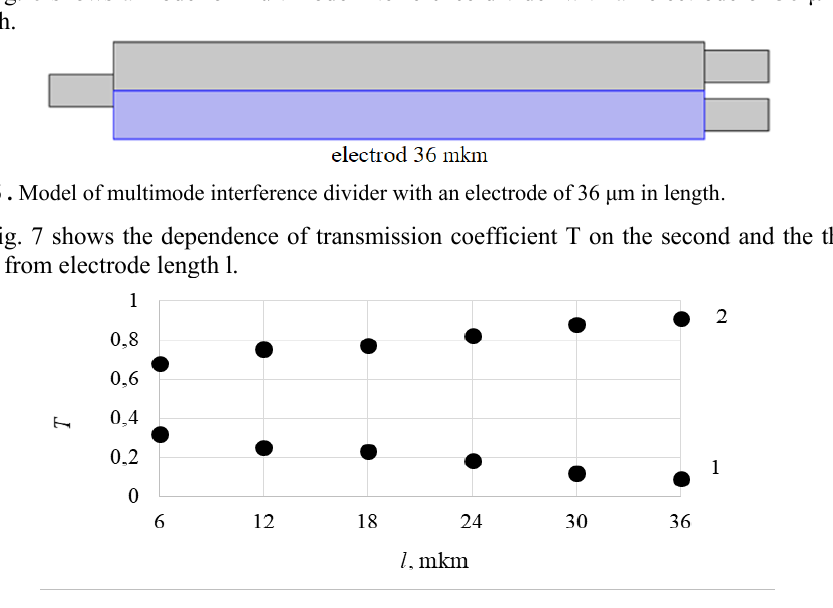
Fig. 7 . The dependence of transmission coefficient T on the second and the third ports from electrode length l: 1) – T2; 2) –